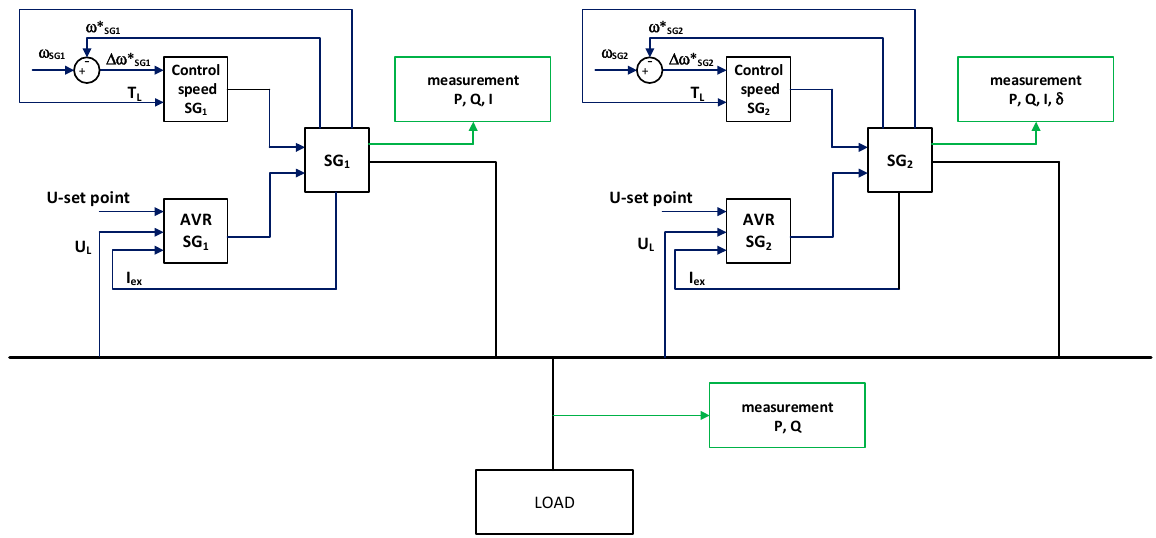
Figure 9. General block diagram of the parallel operation of two generators (SG 1 and SG 2 ) implemented in the Sim Power System program of the Matlab-Simulink environment.